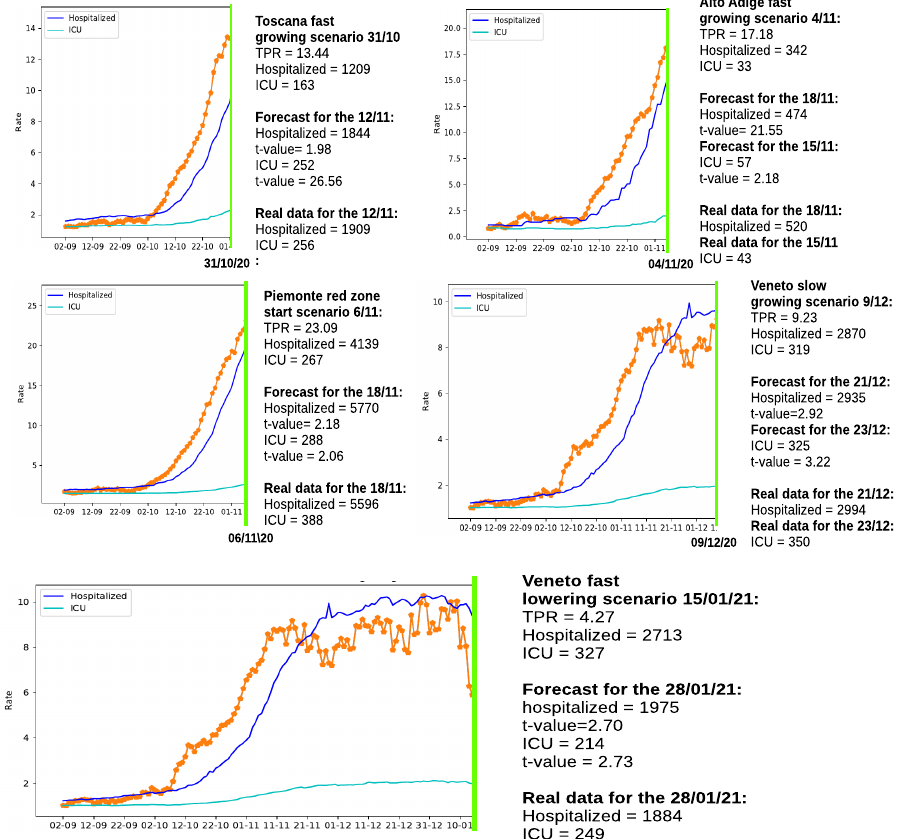
Figure 3. Forecasting hospitalized patients growth in 5 different scenarios for regions: Toscana, Alto Adige, Piemonte, and Veneto (also including a fast lowering example). The orange dotted lines represent the TPR